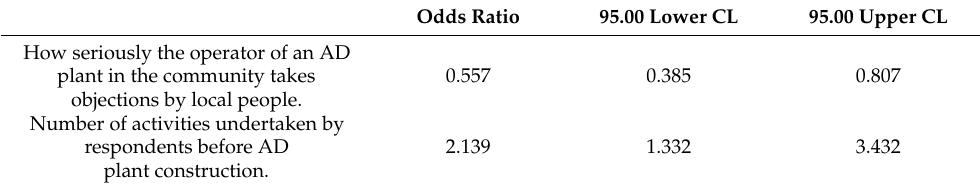
Table 5. Odds ratios of regression